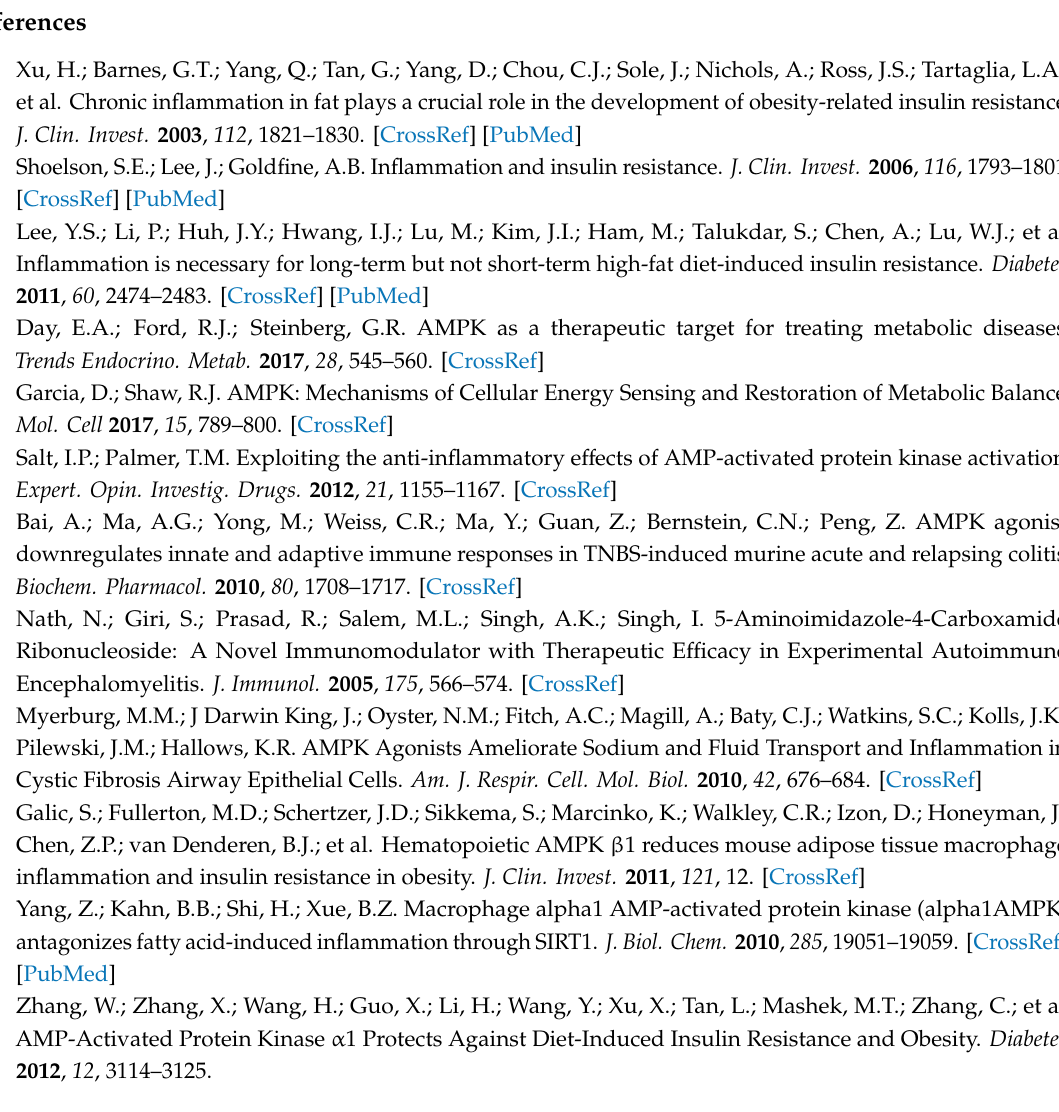
Figure S1: Scheme of extract and isolation, Figure S2: Adipogenic induction of 3T3L1 preadipocytes into adipocytes, Figure S3: The e ff ect of PRE on adipose tissue and liver weight, Figure S3: The e ff ects of PRE on LPS-induced pro-inflammatory gene expression in Raw264.7 cells, Figure S4: The e ff ect of PRE on adipose tissue and liver weight, Figure S5: The e ff ect of PRE on macrophage infiltration and polarization in HFD-fed obese mice, Figure S6: The e ff ect of PRE in liver steatosis, Figure S7: The e ff ect of BF and KJ on LPS-induced NO production and cell viability in Raw264.7 cells, Figure S8: PRE improves insulin sensitivity via suppressing inflammation by activation of AMPK in adipose